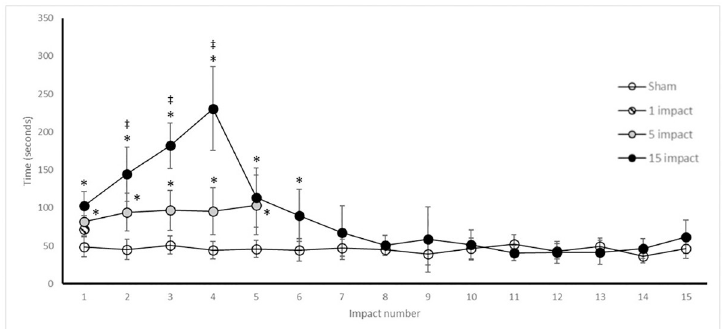
Fig 3. Repetitive mTBI results in transient delay in recovery of righting reflex. Time to regain righting reflex (seconds) following impact or sham control anaesthesia. Values reported as mean ( ± SD). � p < 0.05 difference compared with sham control; ‡ p < 0.05 difference with 1-IMP; # p < 0.05 difference compared with 5-IMP. N = 8 per group.